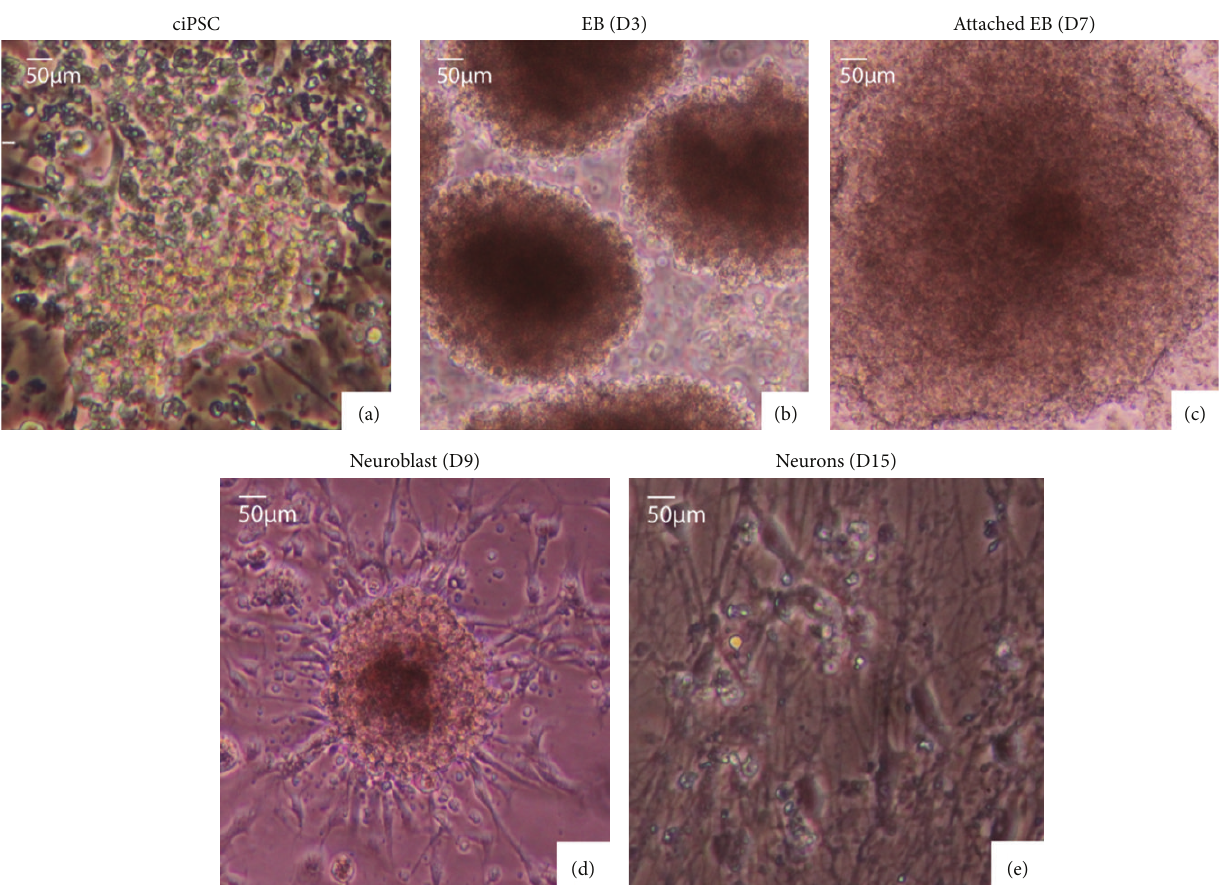
Figure 5: Differentiation of chicken iPSC-like cells (ciPSC), grown in modified 2i+ media, into neurons. (a) Undifferentiated chicken iPSC- like cells in modified 2i+ media at passage 10. (b) Embryoid bodies in suspension culture in embryoid body media, 2 days after initiation of differentiation protocol. (c) Attached embryoid body in transition media, 6 days after initiation of differentiation. (d) Neurite outgrowth (arrow) in N2B27 media at day 9 since the start of differentiation. (e) Developed neurons (arrows) in N2B27 media at day 15.